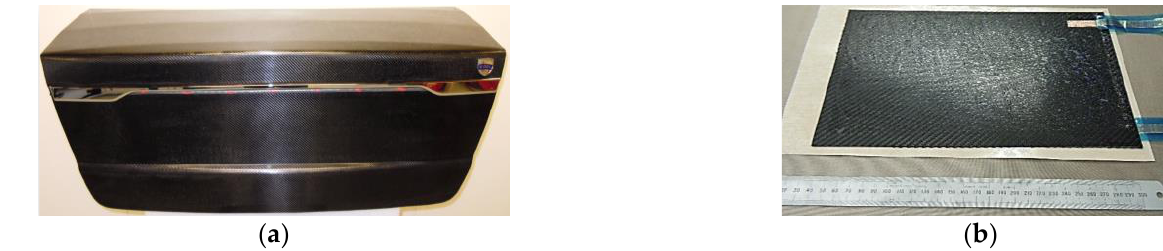
Figure 4. ( a ) A full scale automotive boot lid technology demonstrator and ( b ) a structural supercapacitor cell (adapted from [30]).